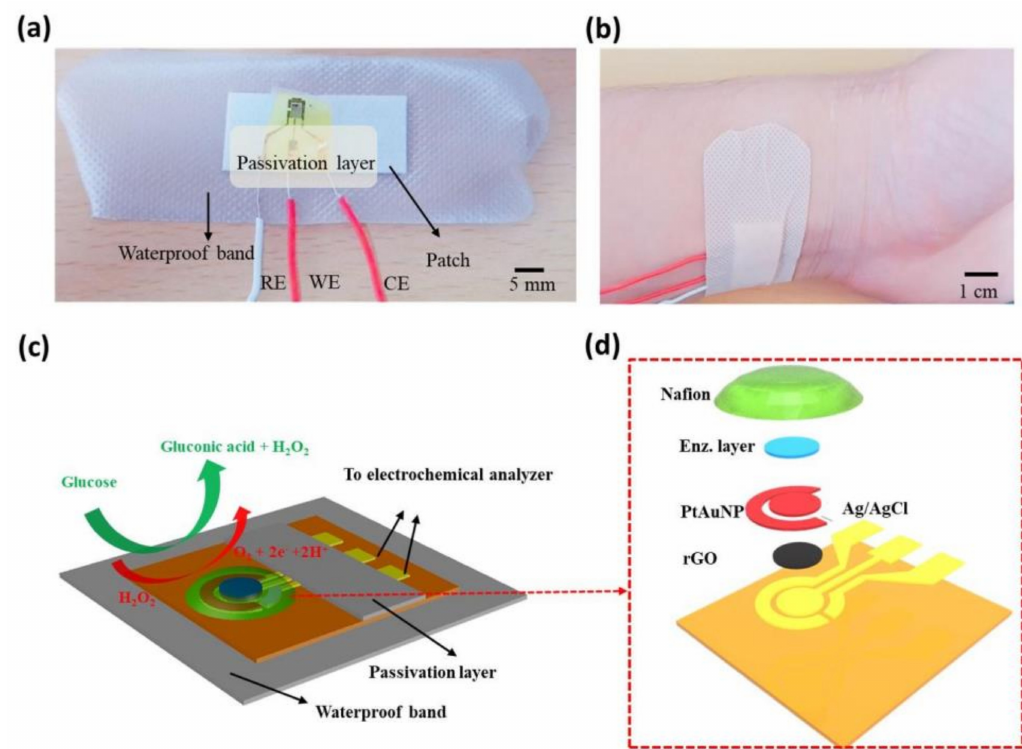
Figure 24. Schematics of the developed wearable glucose biosensor based on sweat. Photos taken with an optical camera ( a , b ) of the developed biosensor. Diagram of the whole biosensor ( c ), with an expanded view ( d ). (Reproduced from [473] with permission. Copyright 2018, Elsevier, Amsterdam, The